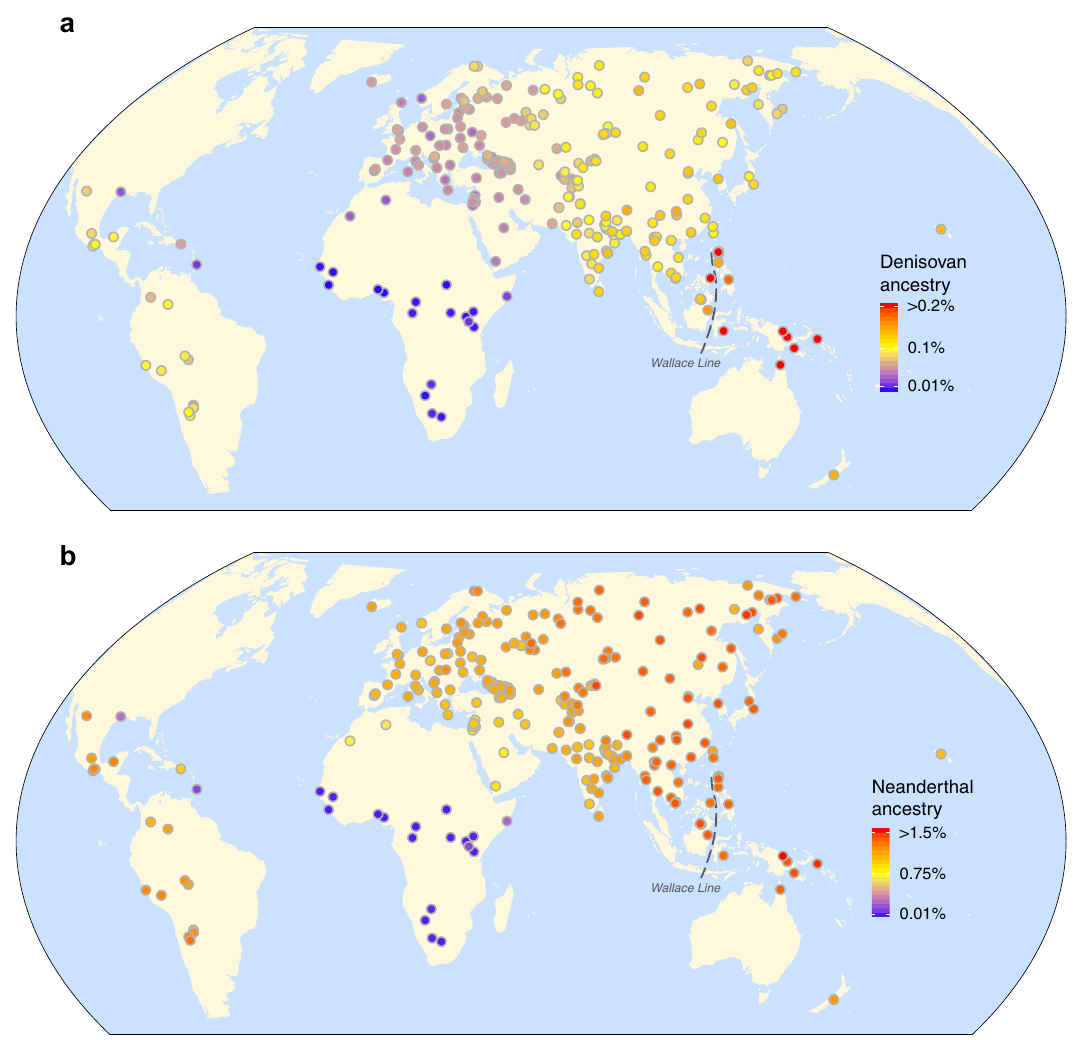
Fig. 3 Archaic introgression in modern humans across the world. a Average proportions of Denisovan introgression in modern humans. Proportions of >0.2% are presented as 0.2% for visualization. b Average proportions of Neanderthal introgression in modern humans. Proportions of >1.5% are presented as 1.5% for